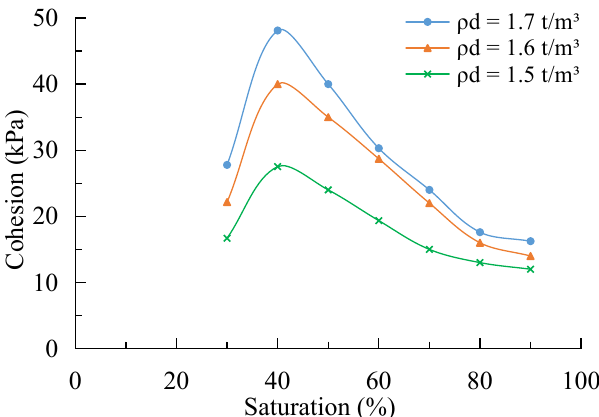
Figure 13. Experiment points of the relationship between cohesion and saturation.